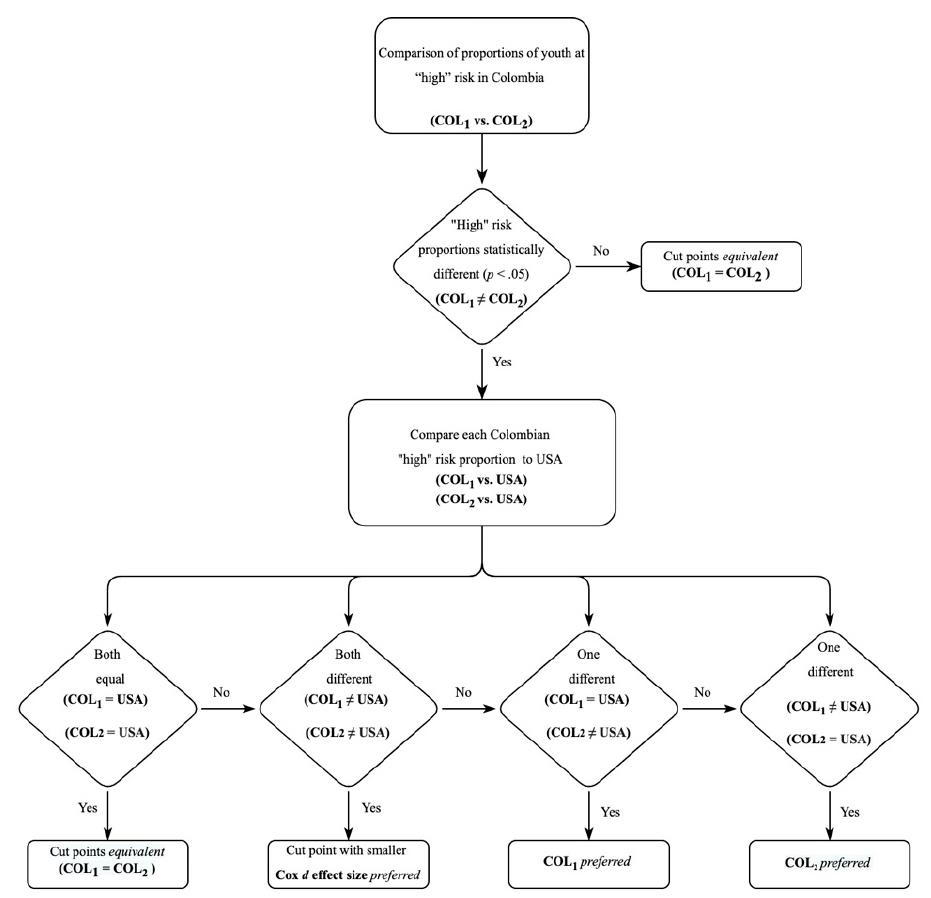
Figure 2. Steps for comparing the proportions of youth at “high” risk.